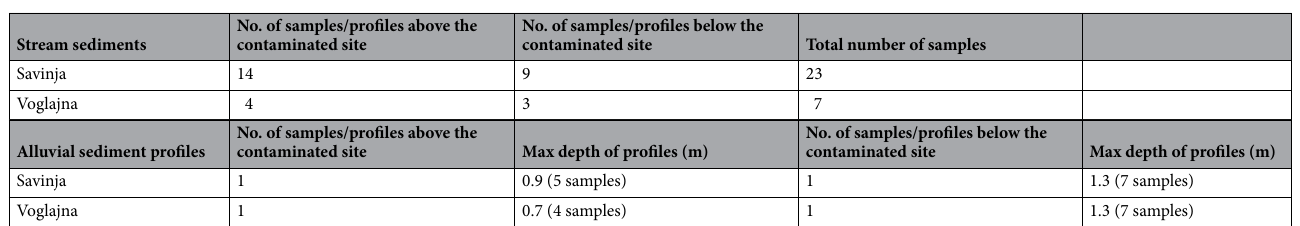
Table 1. Number of samples/profiles above and below the contaminated